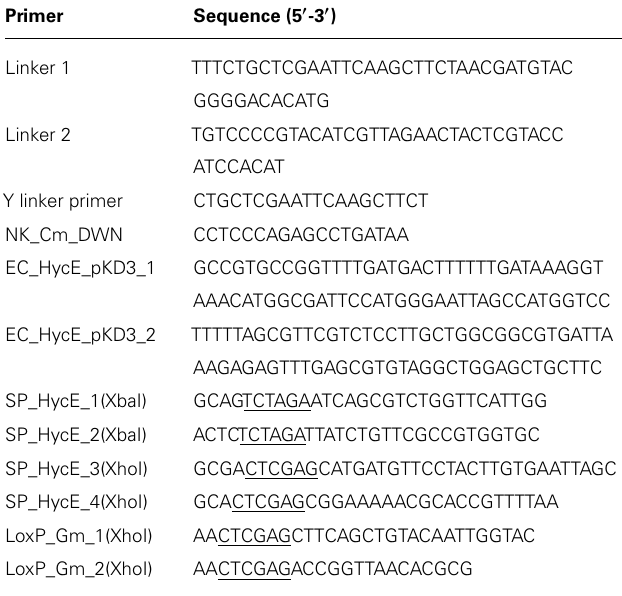
Table 2 | Oligonucleotides used in this